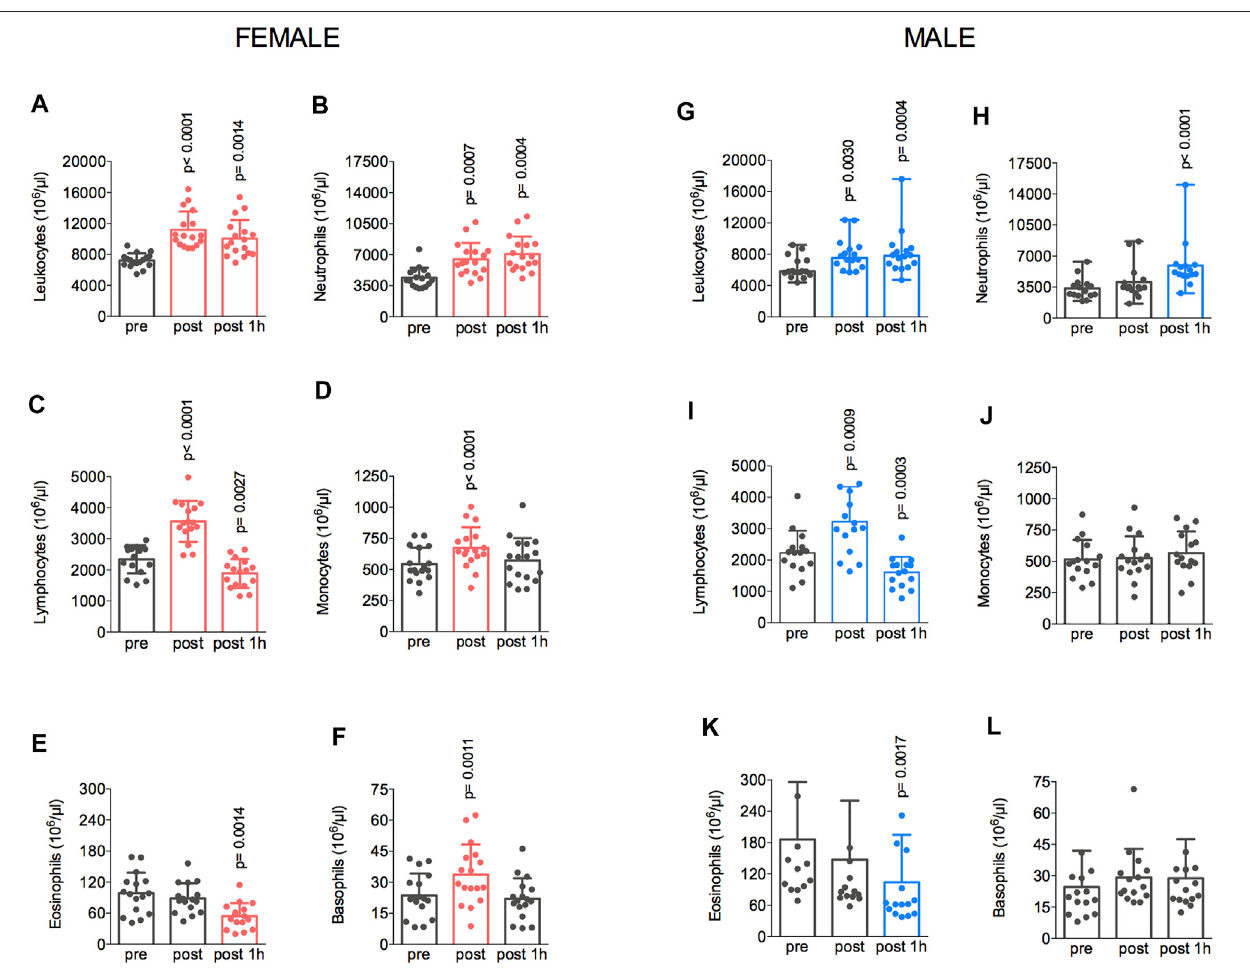
FIGURE 3 | The exercise protocol resulted in elevated total leukocyte (A,G) and lymphocytes (C,I) count immediately after the session. Neutrophil (B,H) count increased at 1 h post-test in both male and female groups. Monocytes (D,J) and basophils (F,L) count also increased 1-h post-test in the female group. Eosinophils (E,K) reduced at 1 h post-test in both male and female groups. Data are shown as means and standard deviations, with p < 0.05 indicating statistical signi fi cance. p Difference between time-points.